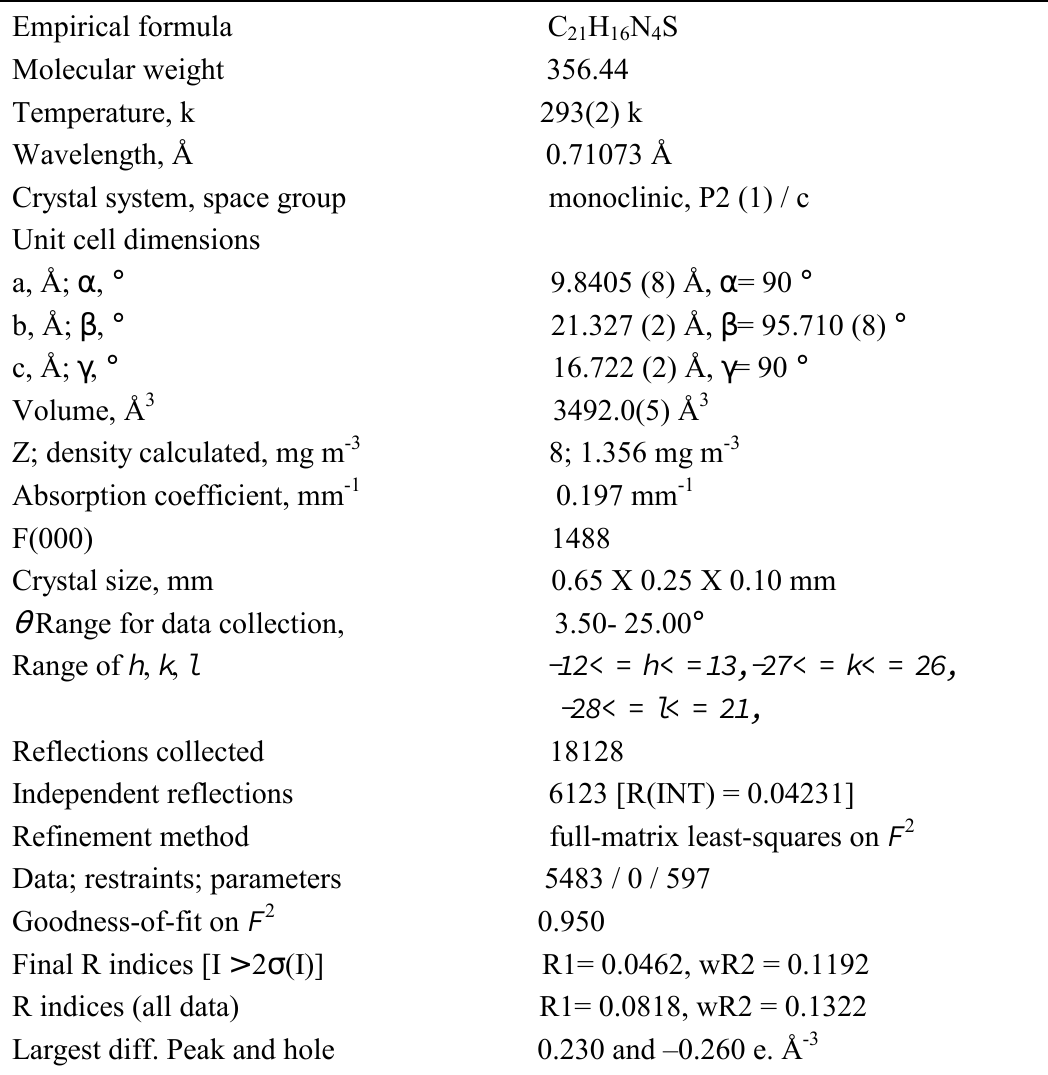
Table 4: Crystal data and structure refinement for